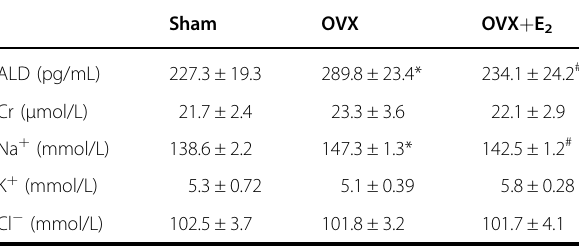
Table 1 Renal functional and electrolytic parameters in rats